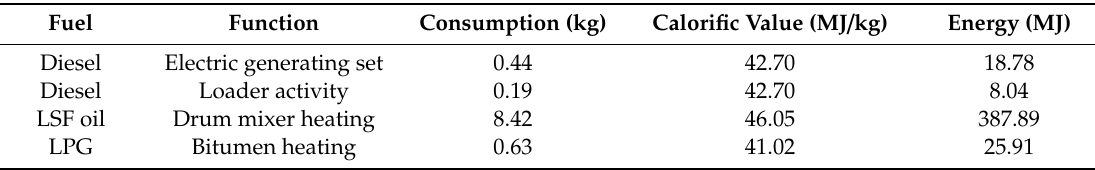
Table 4. Fuel consumption for production of a DU of asphalt mixture in the plant.